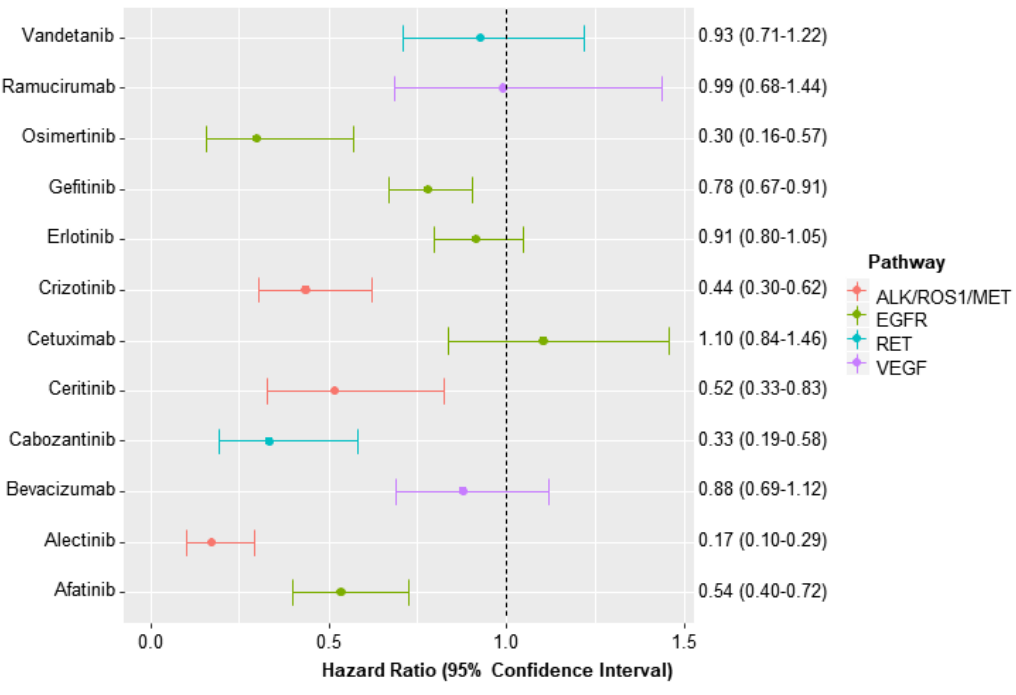
Figure 3. Hazard ratio for progression-free survival of each targeted therapy versus chemotherapy.